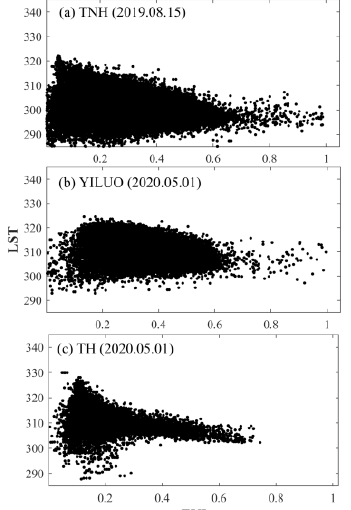
Figure 3. LST-EVI space for the three test areas — TNH (short for Tangnaihai River basin), YILUO (short for Yiluo River basin), and TH (short for Tanghe River basin).